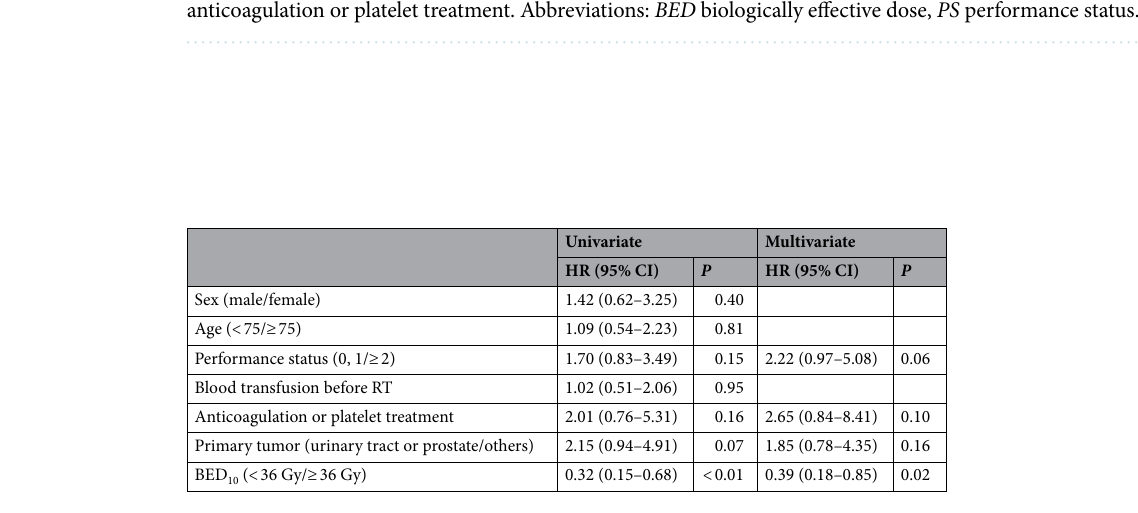
Table 5. Univariate and multivariate analysis of prognostic factors for the hematuria control duration by Cox proportional hazards models. Abbreviations: HR hazard ratio, CI confidence interval, RT radiation therapy, BED biologically effective